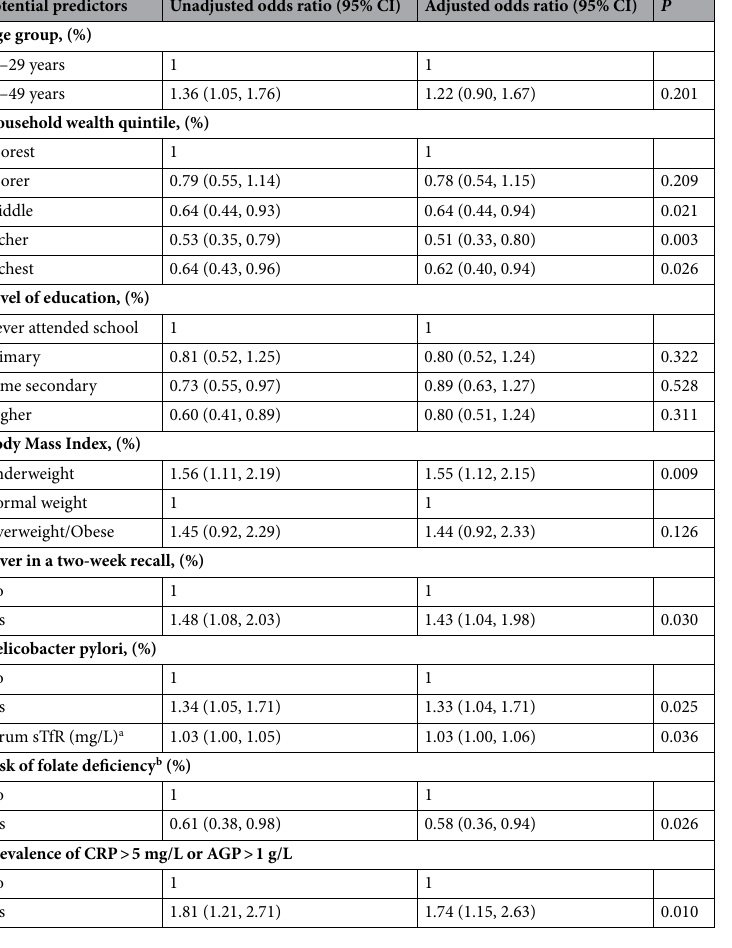
Table 4. Predictors of zinc deficiency among NPW aged 15–49 years, Nepal National Micronutrient Status Survey, Nepal, 2016. Estimates are unadjusted odds ratios and adjusted odds ratios with 95% confidence intervals from logistic regression models, accounting for weighting and complex sampling design. a Biomarker was regression-adjusted to a pooled country reference to adjust for inflammation, using CRP and AGP (ferritin) or AGP only 40 . b Folate cut off based on the risk of megaloblastic anemia defined as RBC folate < 305.0 nmol/L 41